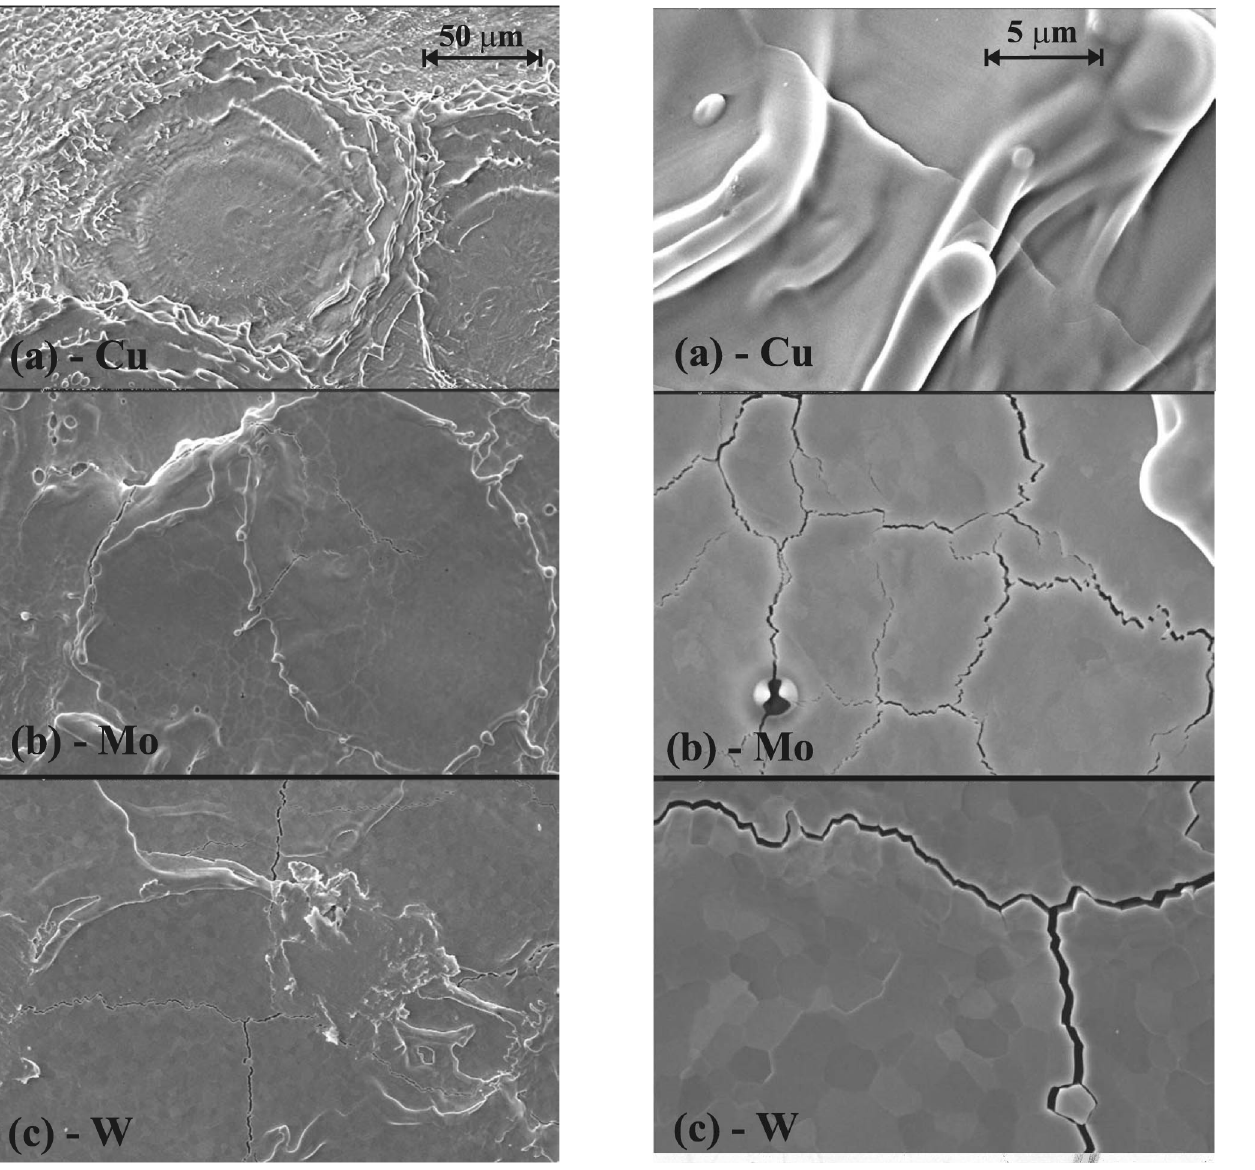
FIG. 8. SEM images of the anode tips for Cu (a), Mo (b), and W (c). The magnification was 500, and the images were recorded with normal incidence. The arrow indicates 50 (cid:14) m .